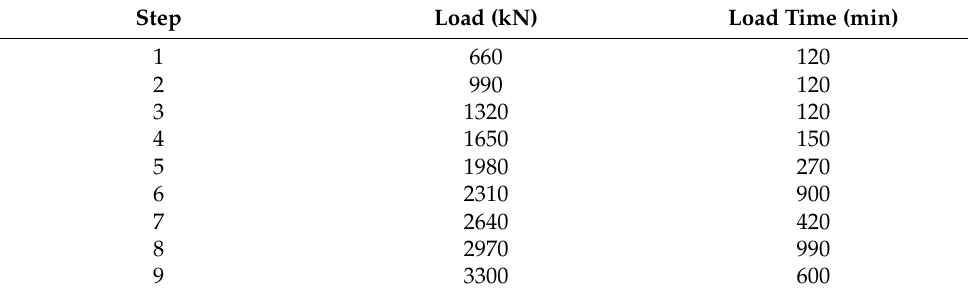
Table 4. Parameters of the tested composite pipe pile.